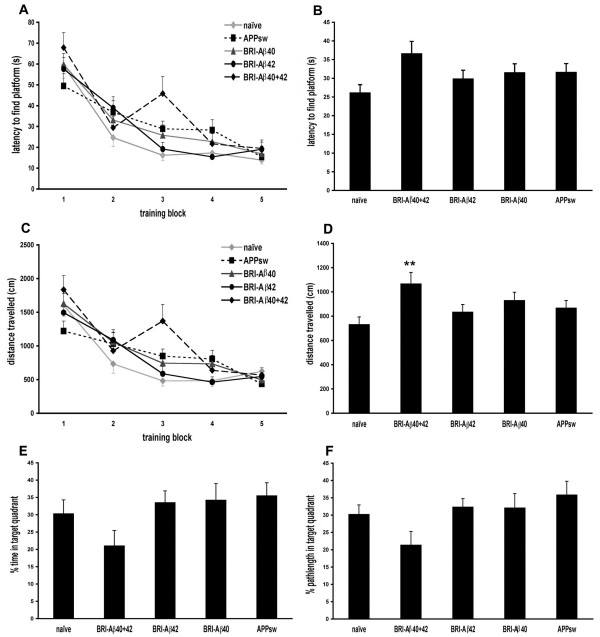
Morris water maze. A. Repeated measures ANOVA on latency to find the platform during acquisition shows that overall the difference between treatment groups was not significant (P = 0.12). However, naïve animals took fewer trials to learn the location of the platform than AAV treatment groups, reaching a minimum latency by day 3. BRI-Aβ40+42 animals had a noticeably higher latency on day 3 of acquisition than other groups. B. BRI-Aβ40+42 animals had the highest mean latency over all 20 trials of all treatment groups (ANOVA P = 0.07). C. Repeated measures ANOVA on pathlength to find the platform during acquisition shows that overall the difference between treatment groups was not significant (P = 0.061). D. BRI-Aβ40+42 animals took a significantly longer pathlength to find the platform over all 20 trials (ANOVA P = 0.02; BRI-Aβ40+42 > naïve, ** p < 0.01). E, F. Animals were put through a probe trial 24 hr after the last training trial. BRI-Aβ40+42 animals showed a non-significant reduction in time (ANOVA P = 0.2) and distance (ANOVA P = 0.13) spent in the target quadrant.